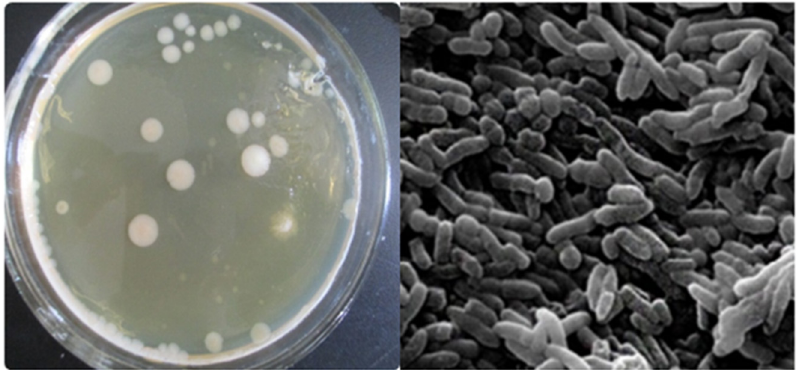
Figure 2. Partial isolated colonies from activated sludge after azo dye acclimatization. The right-hand photo presents the SEM image of one of the isolated